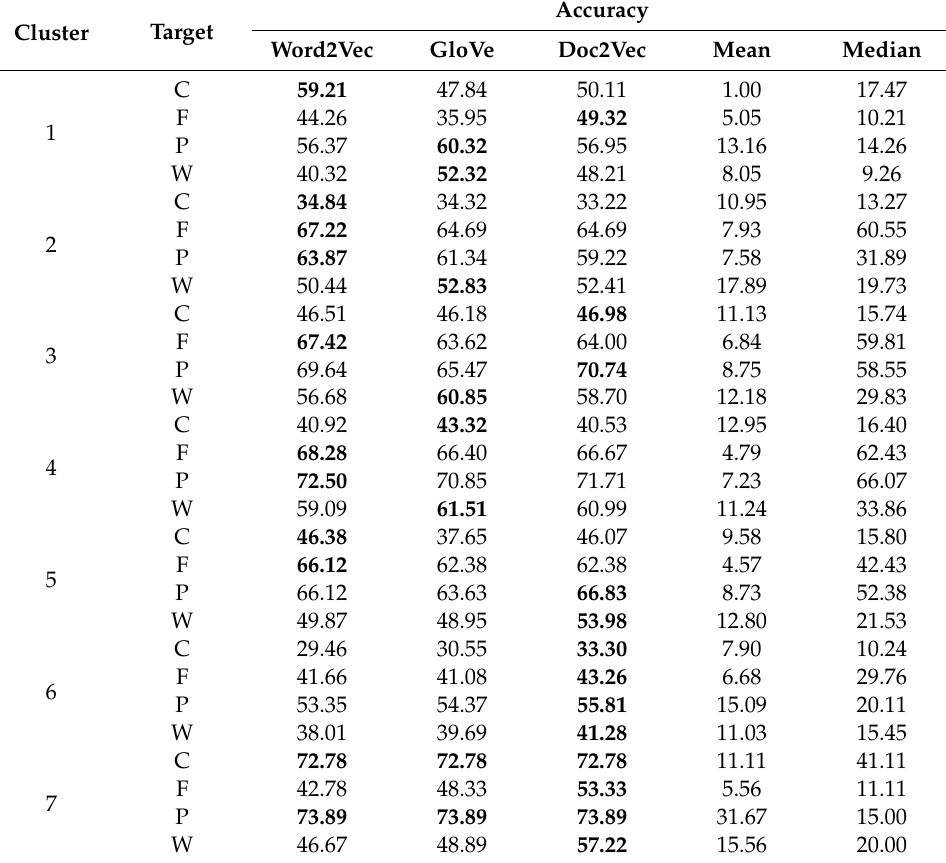
Table5. Accuracypercentagesafterk-foldcrossvalidationoneachclusterobtainedwiththeembeddings for the English names of the food products. Target: C—Carbohydrates, F—Fat, P—Protein, W—Water. The bolded numbers in the table represent the overall best performance for each macronutrient in the given